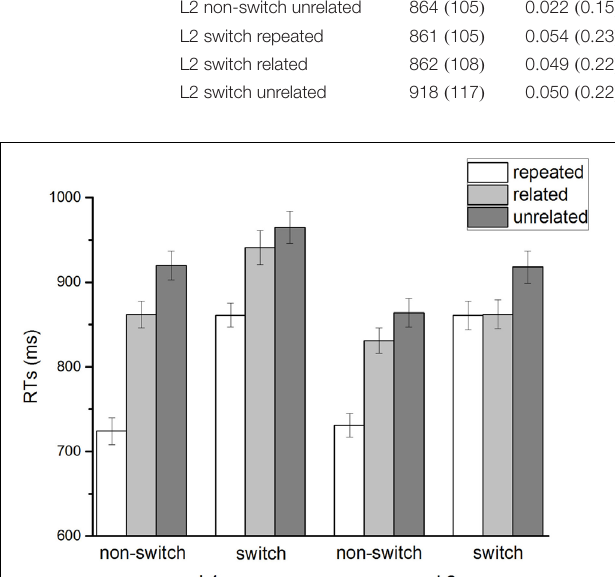
FIGURE 2 | Naming response times (in milliseconds) as a function of language form switching (non-switch and switch), concept switching (repeated, related and unrelated) and naming language (L1 and L2).